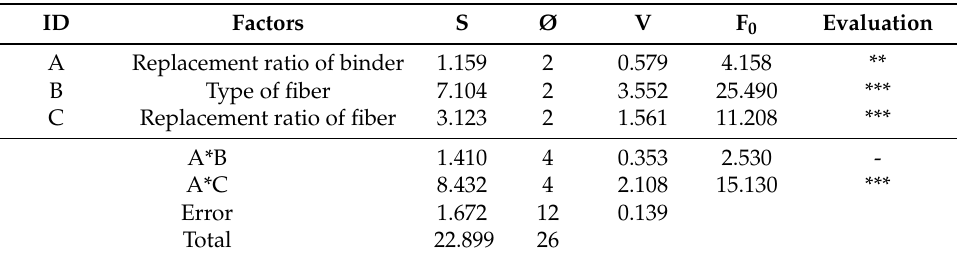
Table 8. Variance analysis for the moisture content ratio of the extrusion